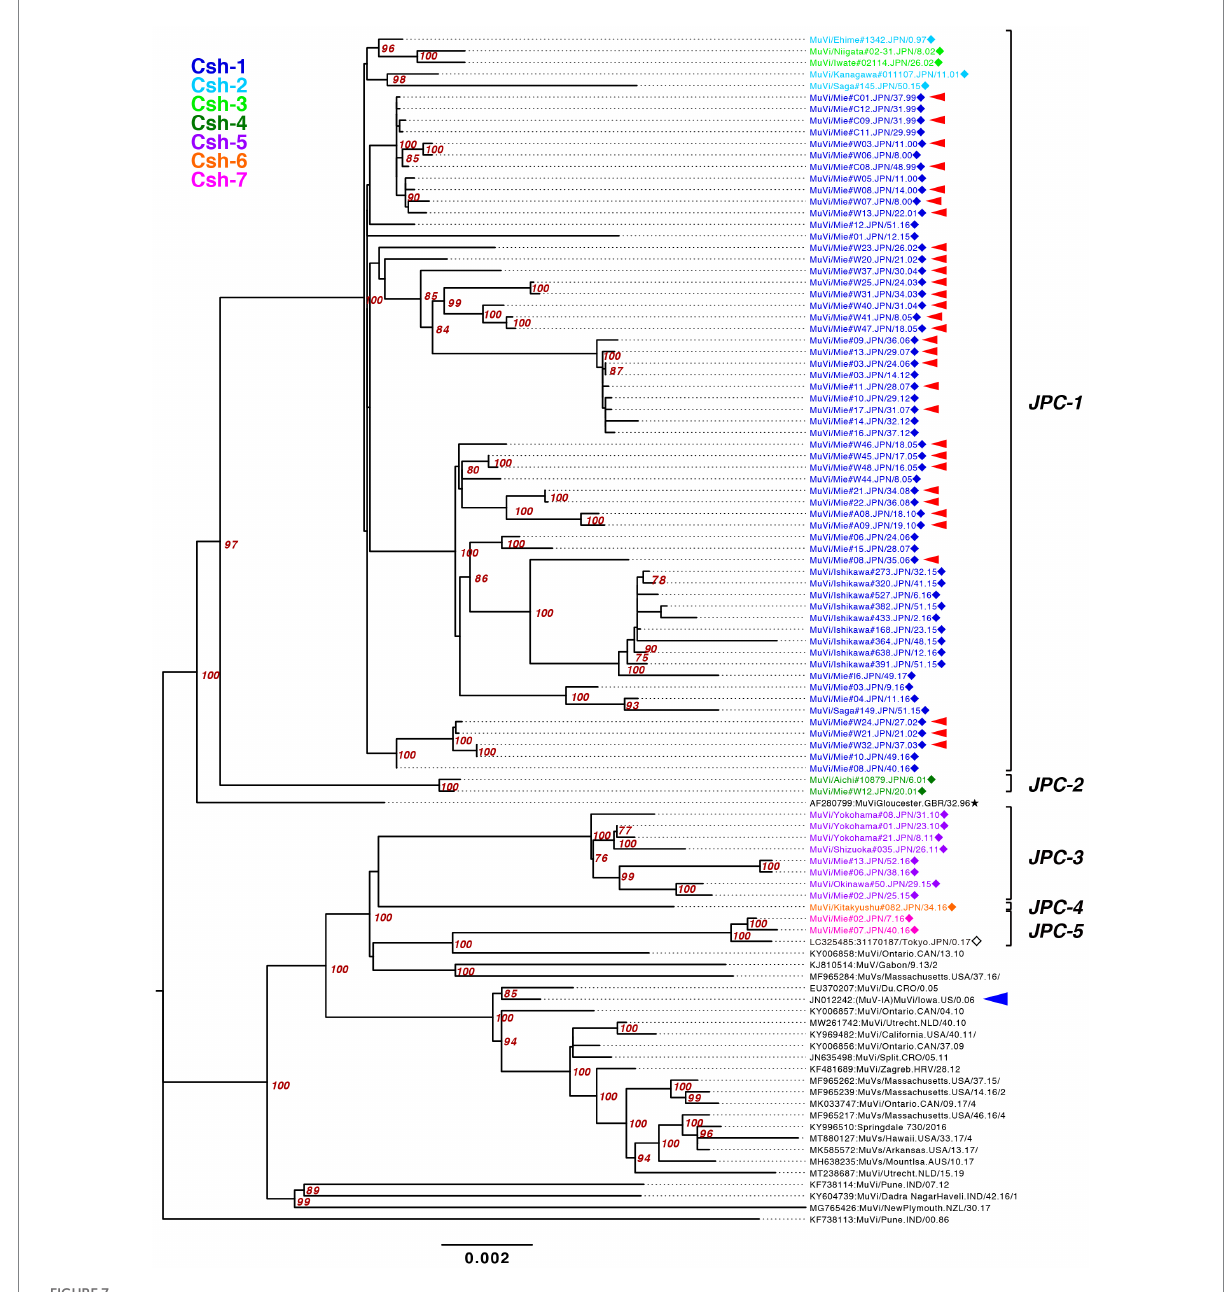
FIGURE 7 Maximum-likelihood phylogenetic tree of the genotype G strains based on WGS-dt. The WHO reference strains are indicated by stars ( ★ ). The strains collected in this study are indicated by a filled rhombus ( ◆ ). The domestic related strains are indicated by an empty rhombus ( ◇ ). Bootstrap values >75% are indicated on the trees. The isolates of this study are color coded according to the provisional clade based on the SH sequences: blue for Csh-1, cyan for Csh-2, green for Csh-3, moss green for Csh-4, purple for Csh-5, orange for Csh-6, and red for Csh-7. Red arrow-heads denote the strains sharing the absolute identical SH gene sequence. Red arrow-heads denote the strains harboring an absolutely identical SH gene sequence. Blue arrow-head denotes the isolate of the large outbreak in Iowa, USA in